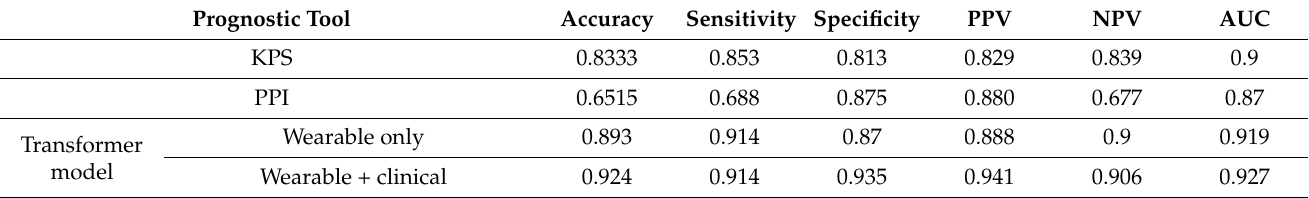
Table 4. Comparison between the accuracy of wearable and traditional prognostic